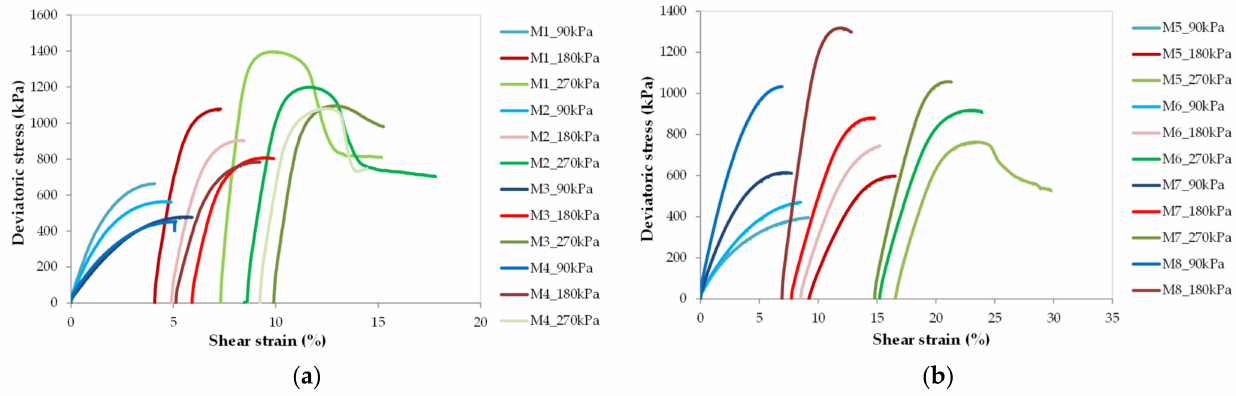
Figure 6. stress-strain characteristic for RCA and RCA–RTW mixtures. ( a ) RCA mixtures: M1, M2, M3, and M4; ( b ) RCA–RTW mixtures: M5, M6, M7,